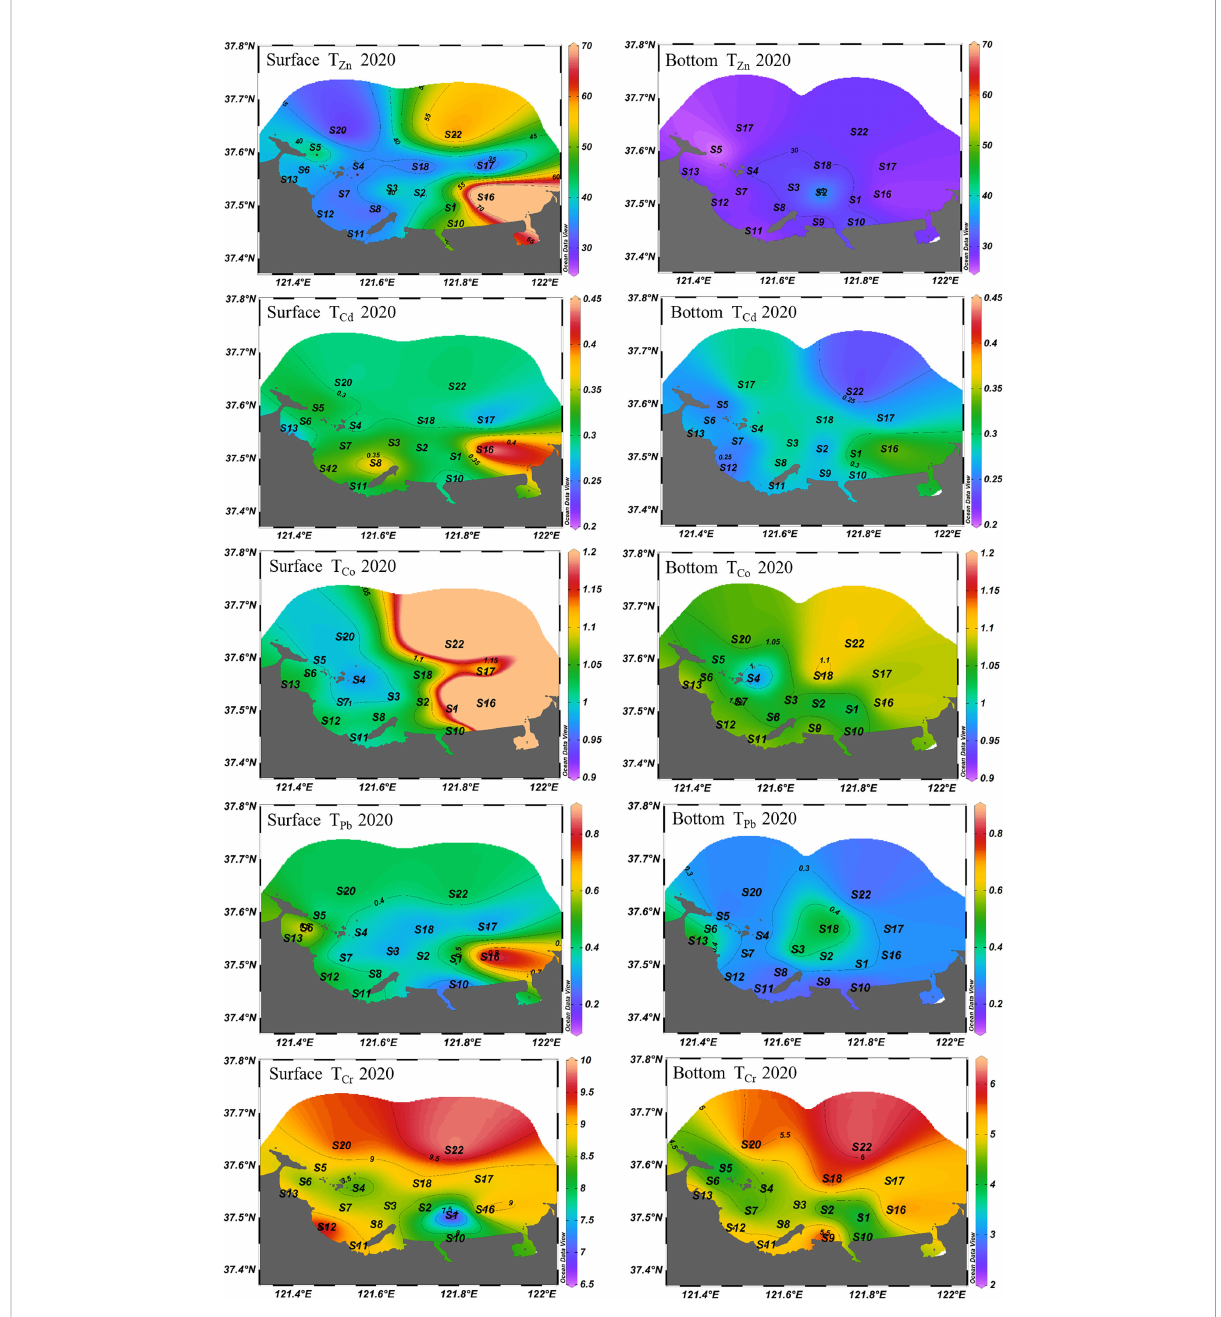
FIGURE 4 Spatial distribution of Zn, Cd, Co, Pb, and Cr (unit: m g/L) in the YOA in August 2020 for surface seawater and bottom